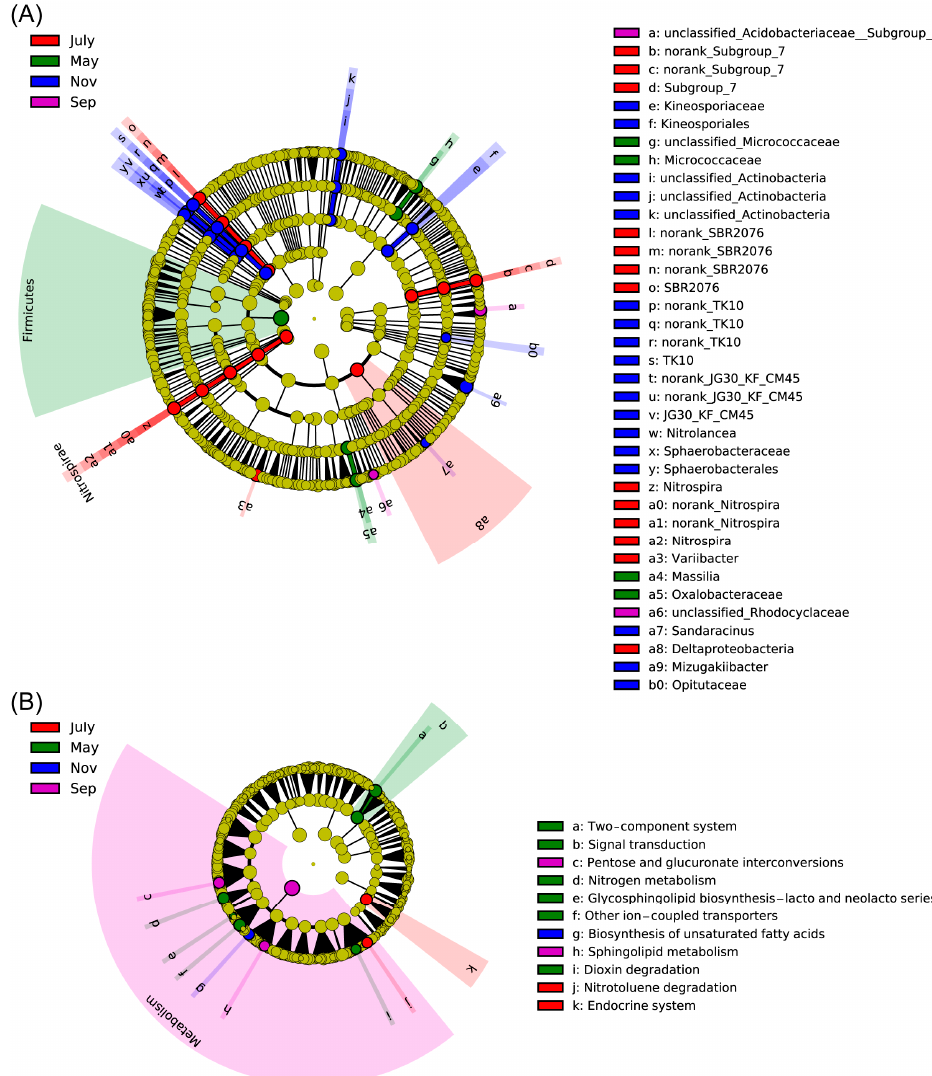
Figure 6. Cladogram plotted from LEfSe comparison analysis indicating the taxonomic representation of statistically and biologically consistent differences of identified biomarkers among different time point. Differences were represented in the color of the most abundant taxa (green stands for May, red for July, purple for Sep, blue represents Nov and yellow were non-significant). Each circle’s diameter was proportional to the given taxon’s relative abundance. ( A ) Cladogram indicating the phylogenetic distribution of bacteria lineages under seasonal changes of sugarcane; lineages with LDA values higher than 3.5 were displayed. Circles represent phylogenetic levels from phylum to genus from the inside outwards. ( B ) KEGG level 1~3 functional pathways differentially abundant by different stages. Differentially abundant KEGG functional pathways in sugarcane’s PICRUSt predicted metagenome were showed by using LEfSe, lineages with LDA values higher than 2.5 were displayed.